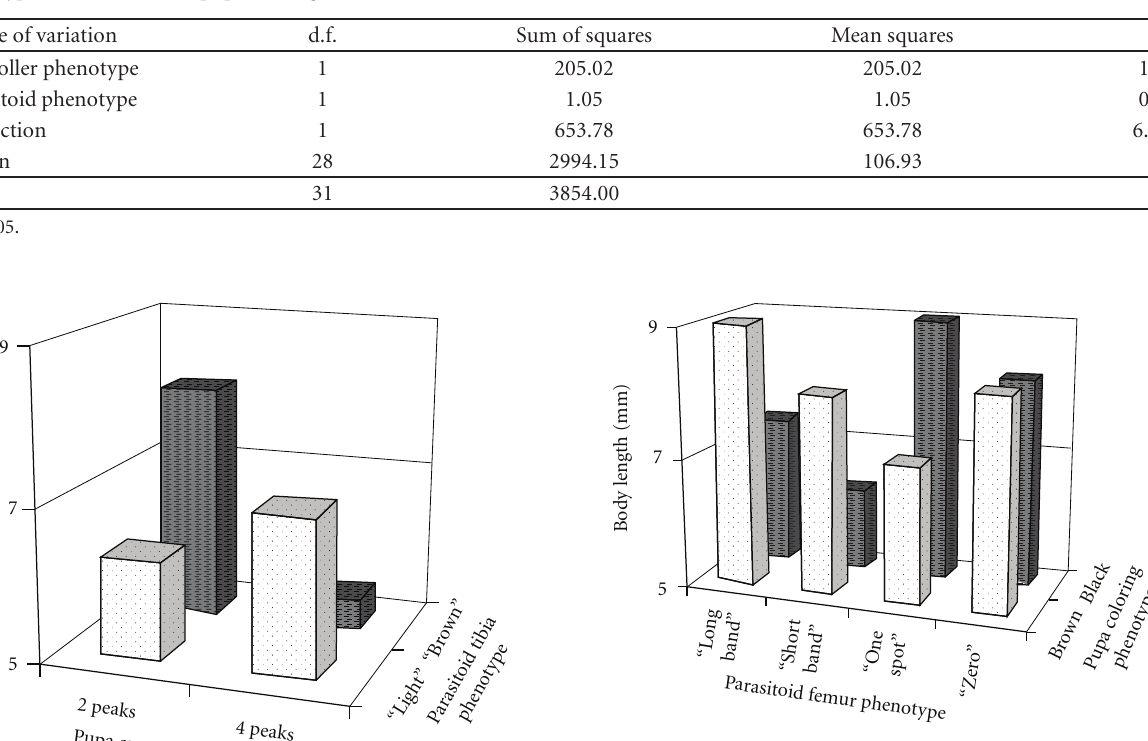
Table 1: Results of two-way ANOVA on the parasitoid body lengths variation in dependence from parasitoid tibia phenotype and cremaster phenotype of the host insect pupa (see Figure 4).